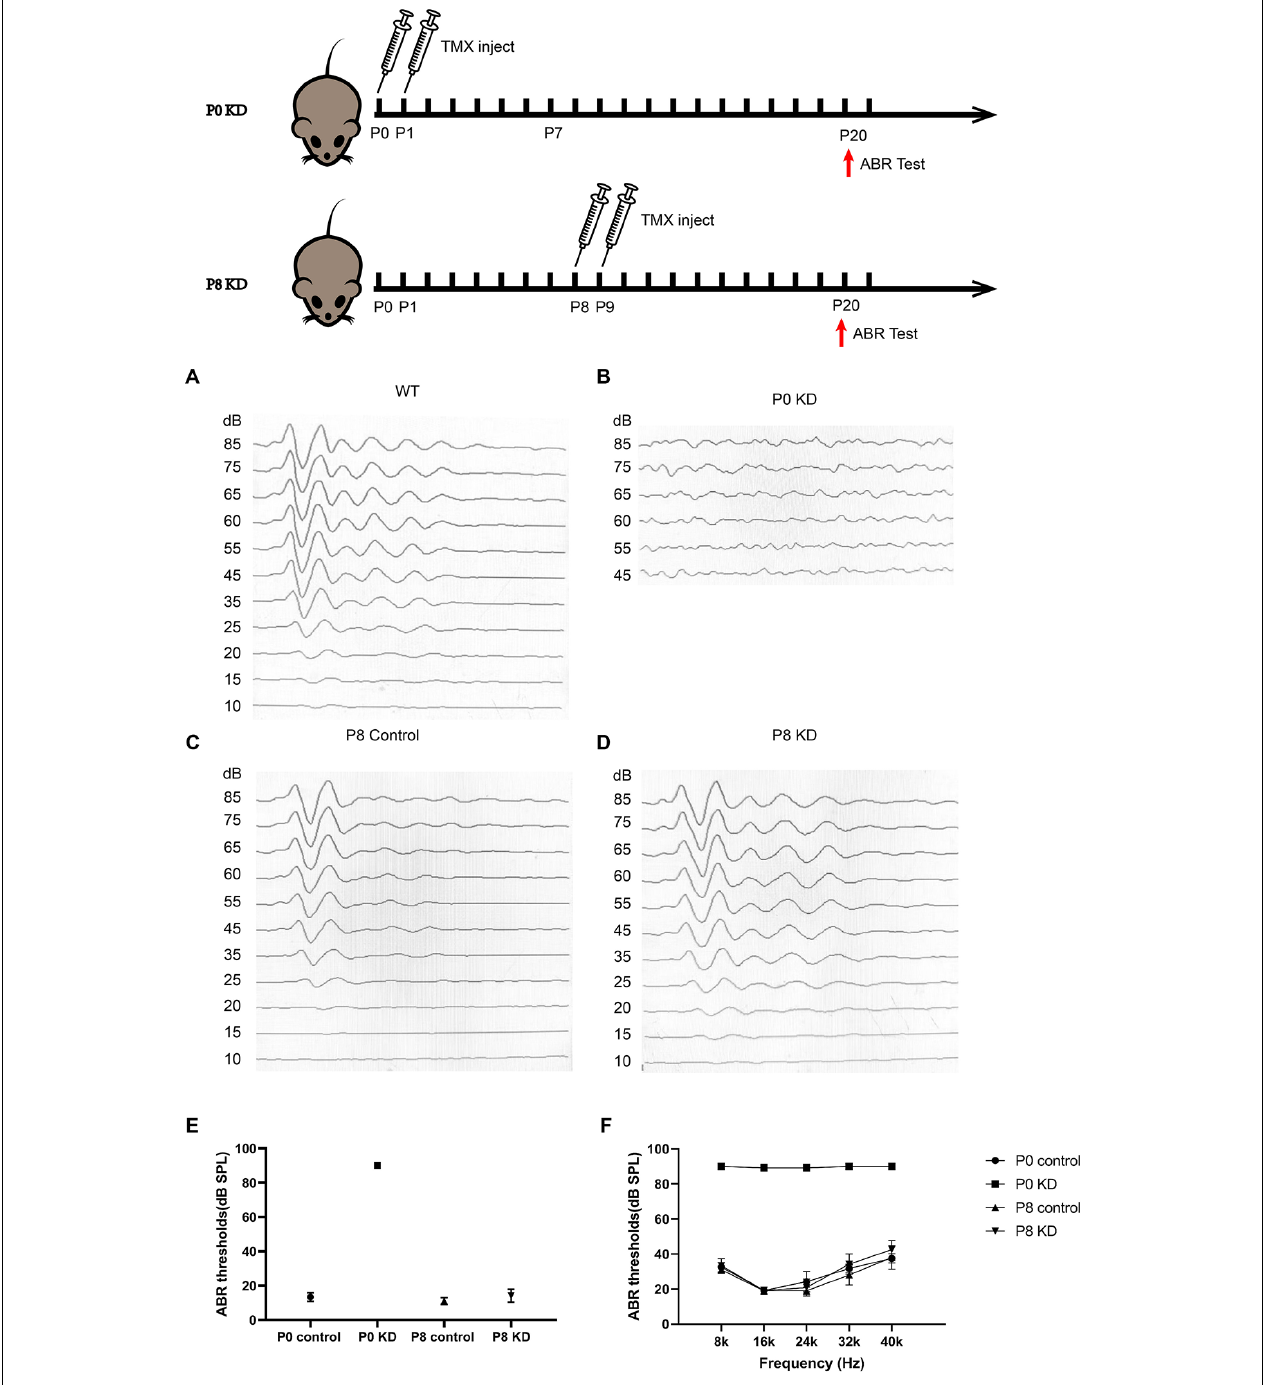
FIGURE 1 | Mice that Cx26 were knockdown at P0 have severely impaired hearing. Auditory thresholds ( n = 6 in each group) evoked by click (A–E) or tone-bursts (F) were measured in the P0 control, P0 KD, P8 control, and P8 KD groups. All ABR tests were performed at P20.